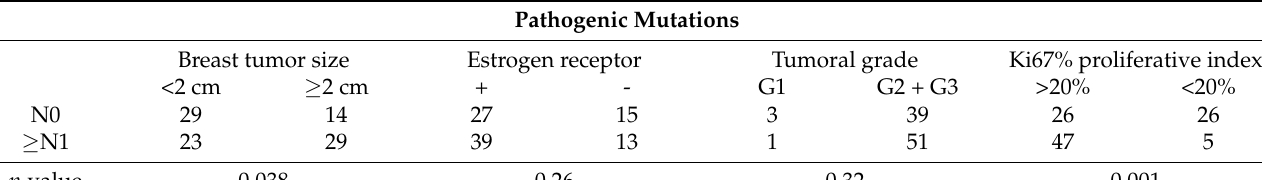
Table 3. Axillary nodal status and immunohistochemistry and histology findings. Pathogenic Mutations